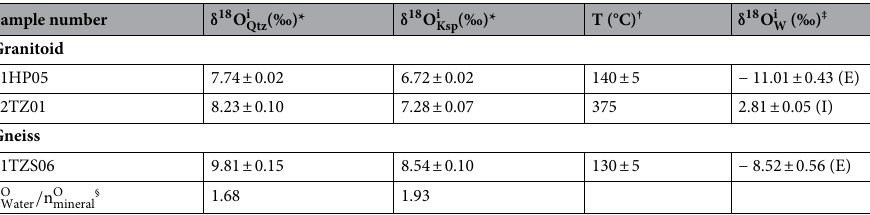
18 O i Table 1. Parameters of theoretical inversion for δ W values of the externally (E) infiltrated and internally (I) buffered water. *Initial quartz ( δ 18 O i Qtz ) and alkali feldspar ( δ 18 O i Ksp ) oxygen isotopes are calculated with the observed zircon δ 18 O values (Table S1) at magmatic or metamorphic temperatures, respectively. The initial oxygen isotopes of sample 01HP05 are calculated at 740 ± 1 °C, which is retrieved from oxygen isotopes of quartz-zircon pair from sample 01HP04 and assumed a similar magmatic temperature on the pluton scale. The averaged magmatic temperature of 780 ± 20 °C from the Tianzhushan pluton, however, is adopted for sample 02TZ01. The metamorphic temperature of 610 ± 20 °C is bracketed through samples 00DB63, 00DB64 and 01TZS07 and a common thermal regime on the orogenic scale is assumed for sample 01TZS06. † Re-equilibration temperatures are calculated with the observed oxygen isotopes of quartz-alkali feldspar pairs. Owing to the lack of repetitive measurements for sample 02TZ01 (Table S1), its 1SD of re-equilibration temperature is statistically not assigned. ‡ Theoretically inverted from the open systems for samples 01HP05 and 01TZS06 whereas from the closed system for sample 02TZ01. § Ratio of exchangeable oxygen content between water and an indicated